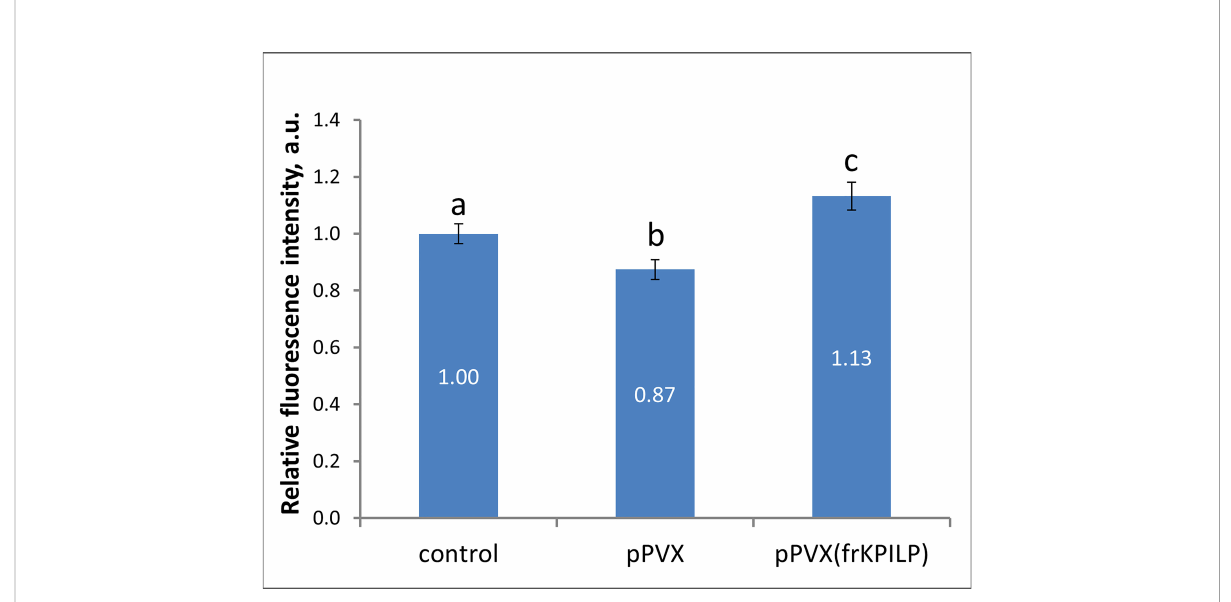
FIGURE 4 KPILP affects callose deposition around PD. Relative callose levels at PD as estimated by measurement of aniline blue-stained callose fl uorescence intensity in N. benthamiana plants with PVX systemic infection and KPILP downregulation compared to the intact plants. The level callose in control plants was taken as 1. Mean values in arbitrary units (a.u.) and standard errors are presented. Bars without shared letters indicate signi fi cant differences at p<0.05 (ANOVA, Tukey ’ s